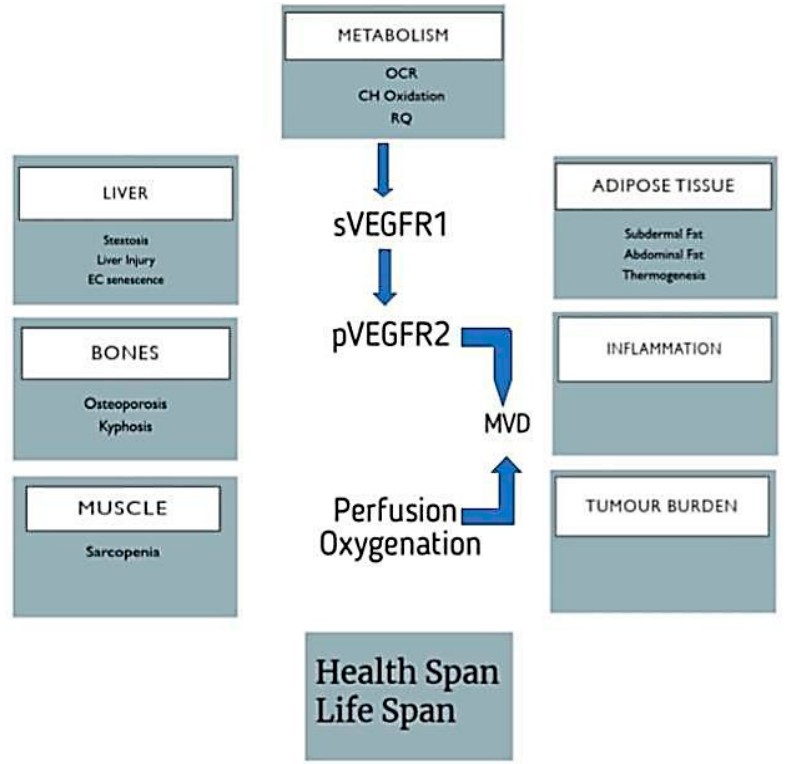
Figure 7. Role of VEGF in different diseases such as liver injury, osteoporosis, kyphosis, sarcopenia, tumor burden, and inflammation [80,81,85,86]. tumor burden, and inflammation